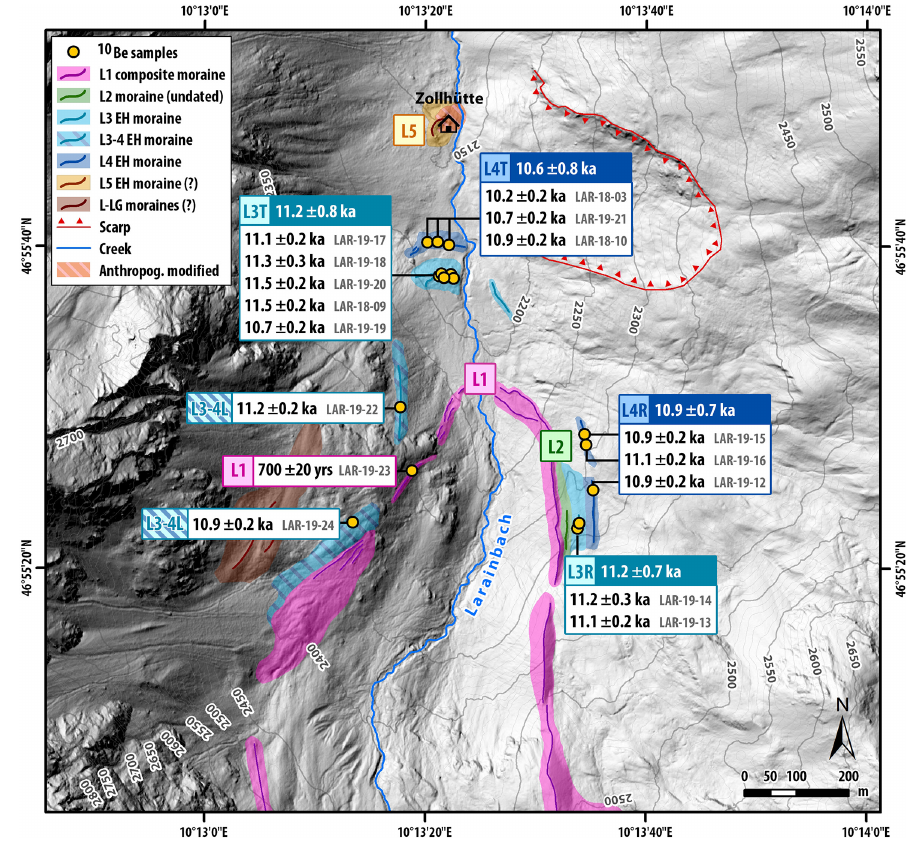
Figure 4. Holocene moraine chronology of Laraintal with moraine ages displayed. The 10 Be sample collected from the L1 suggests an early LIA advance around 1300CE. Lateral and terminal moraines outboard L1 yield EH ages, which agree well with the Jamtal moraine record. DEM provided by © Land Tirol (resolution 1m; Land Tirol – tiris,